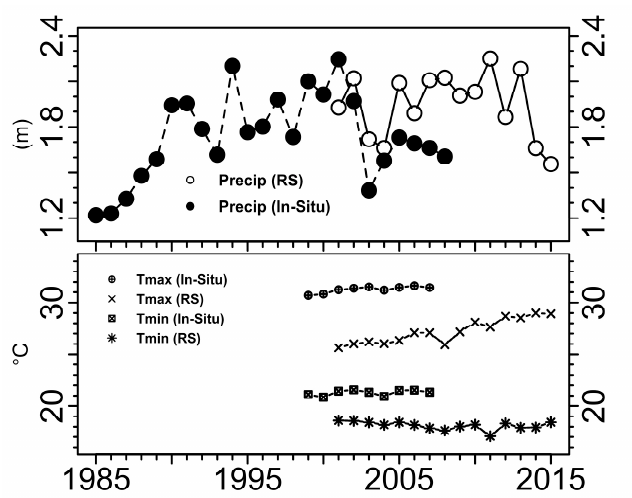
Figure 4. The Lower Mekong River Basin time series data. Annual aggregated weighted average precipitation in meters over the LMRB using satellite-based remote sensing (RS) and in-situ data. Mean annual aggregated weighted air temperature pattern (maximum and minimum air temperatures) in degrees Celsius using remote-sensing-calculated products and in-situ data.